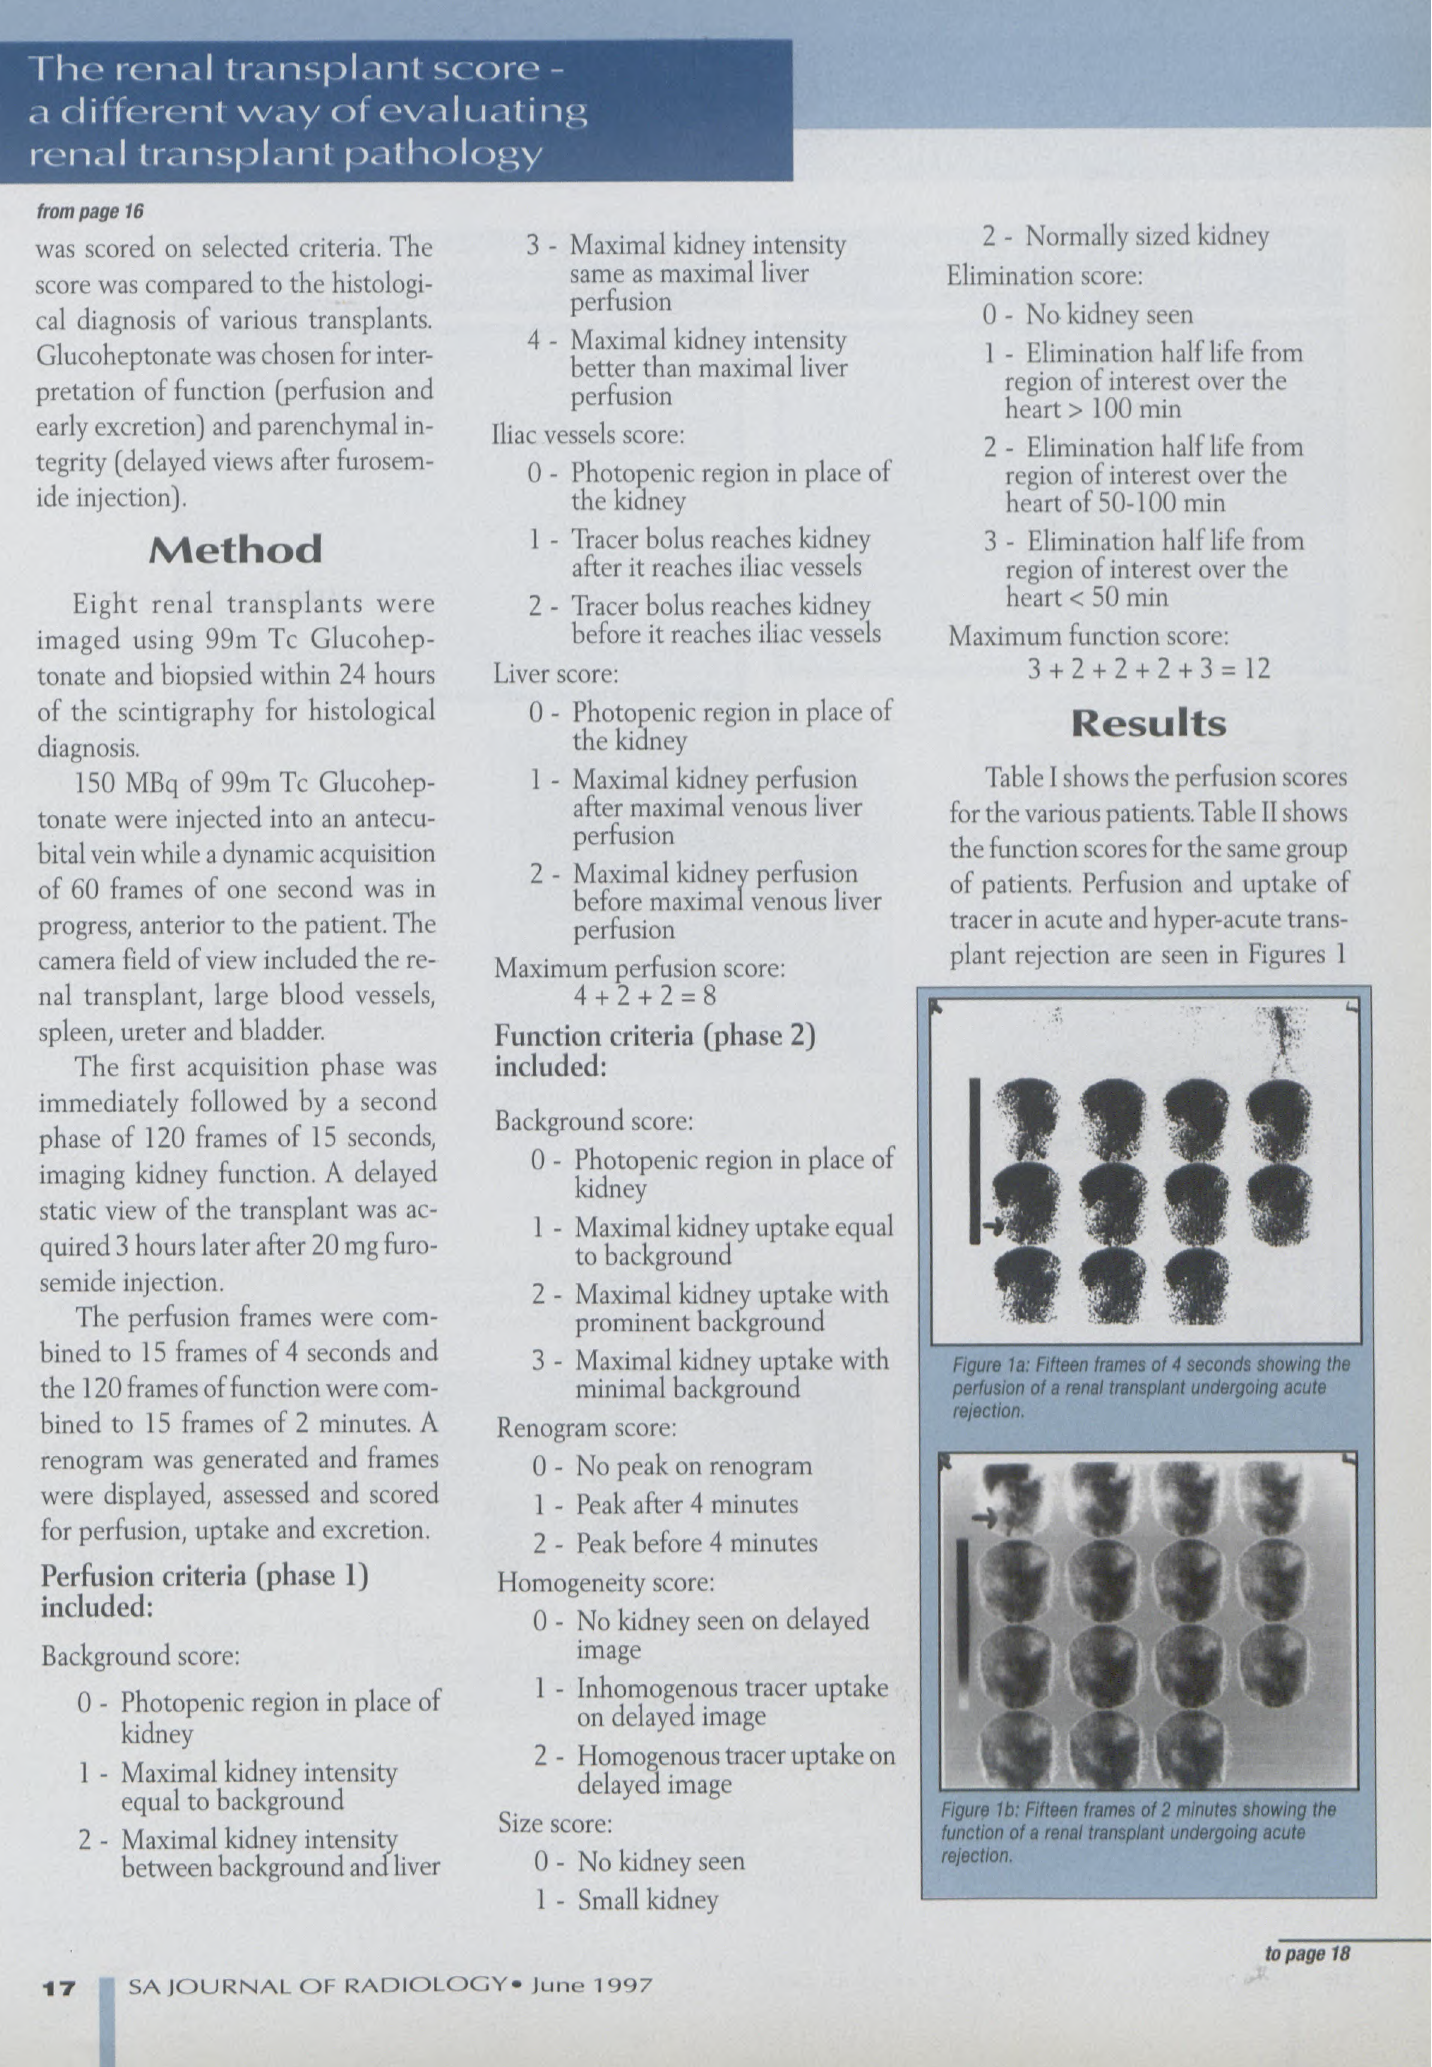
Figure 1 b: Fifteen frames of 2 minutes showing the function of a renal transplant undergoing acute